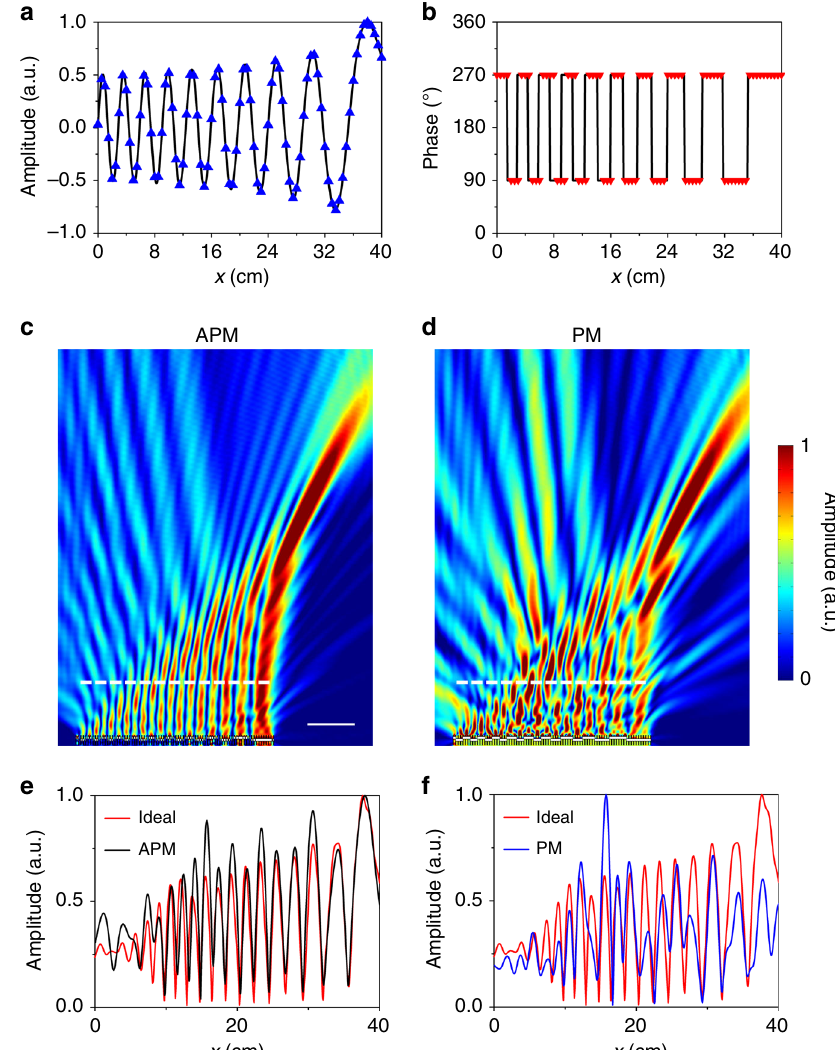
Fig. 3 Formation of high-quality Airy beam. a , b Amplitude pro fi le in a and phase pro fi le in b at the surface of the LAM for generating the Airy beam. The LAM consists of 80 discrete unit cells (triangles). c , d Simulated pressure fi elds of Airy beams produced by the APM in c and PM in d . Scale bar, 10 cm. e , f Distributions of pressure amplitude on the dashed lines in c and d . The result for the perfect Airy beam is calculated by Eq. (7), which is displayed for comparison (red